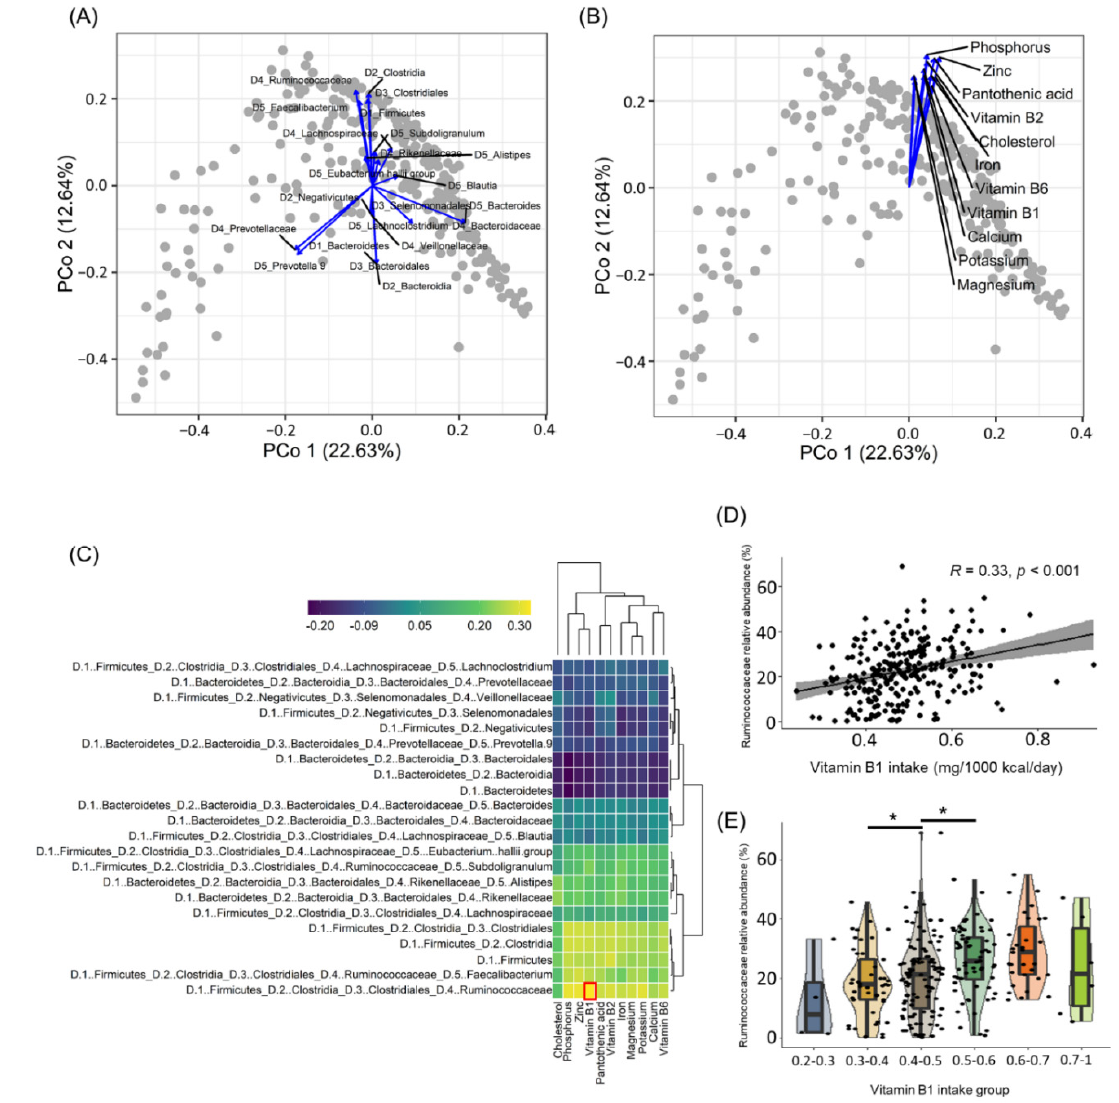
Figure 1. Correlation between gut bacterial community and nutrients. ( A , B ) Principal coordinate analysis of the Bray–Curtis distance for genus-level relative abundance data. Covariates of the bac- terial relative abundance and nutrients intake were identified by calculating the association between each continuous data and genus-level community ordination with the envfit function in the vegan R package. Variables that have been significantly related to coordinates are described ( p -value < 0.001). ( C ) Spearman correlation analysis was performed to elucidate the relationship between gut bacterial relative abundance and nutrients ( n = 257; p -value < 0.05 [|r| > 0.12]). The red square is the result of the highest correlation. ( D ) Correlation between the Ruminococcaceae family and vitamin B1 is shown by scatterplots. ( E ) Boxplot for comparison of Ruminococcaceae family relative abundance between groups grouped by vitamin B1 intake (vitamin B1 intake groups; blue : 0.2-0.3 mg/1000 kcal/day, yellow: 0.3-0.4 mg/1000 kcal/day, brown: 0.4-0.5 mg/1000 kcal/day, dark green: 0.5-0.6 mg/1000 kcal/day, orange: 0.6-0.7 mg/1000 kcal/day, green: 0.7-1 mg/1000 kcal/day). * p -value < 0.05.